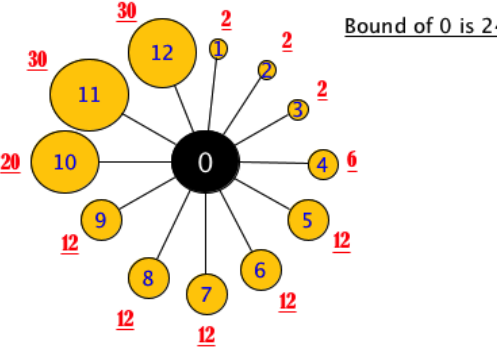
Figure 3. A scheme of a node 0 and its neighbors, the node sizes are proportional to value of bound. The bound values, calculated according to Theorem 2 for α = 0.5, are given in red underlined text for each neighbor.